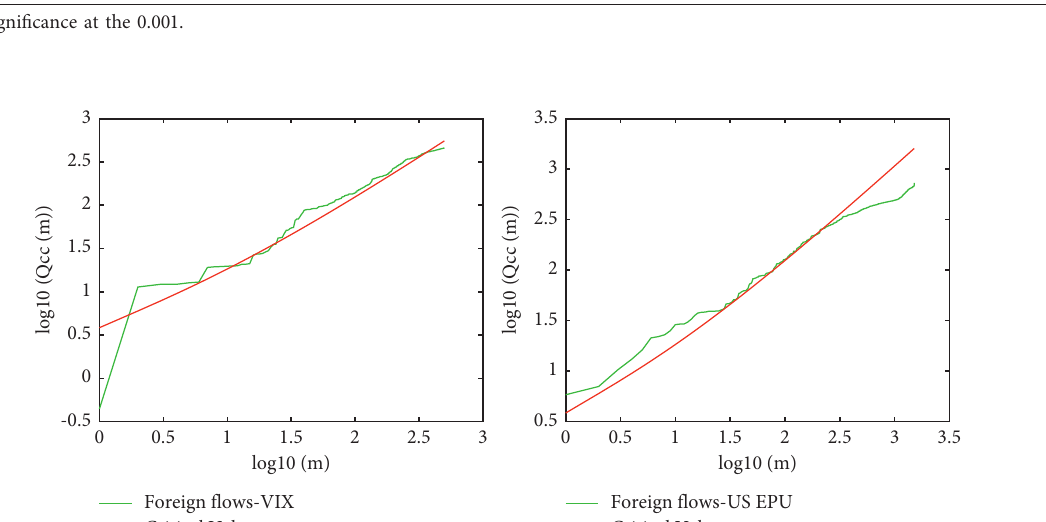
Figure 2: The cross-correlation statistics Q market and US EPU.